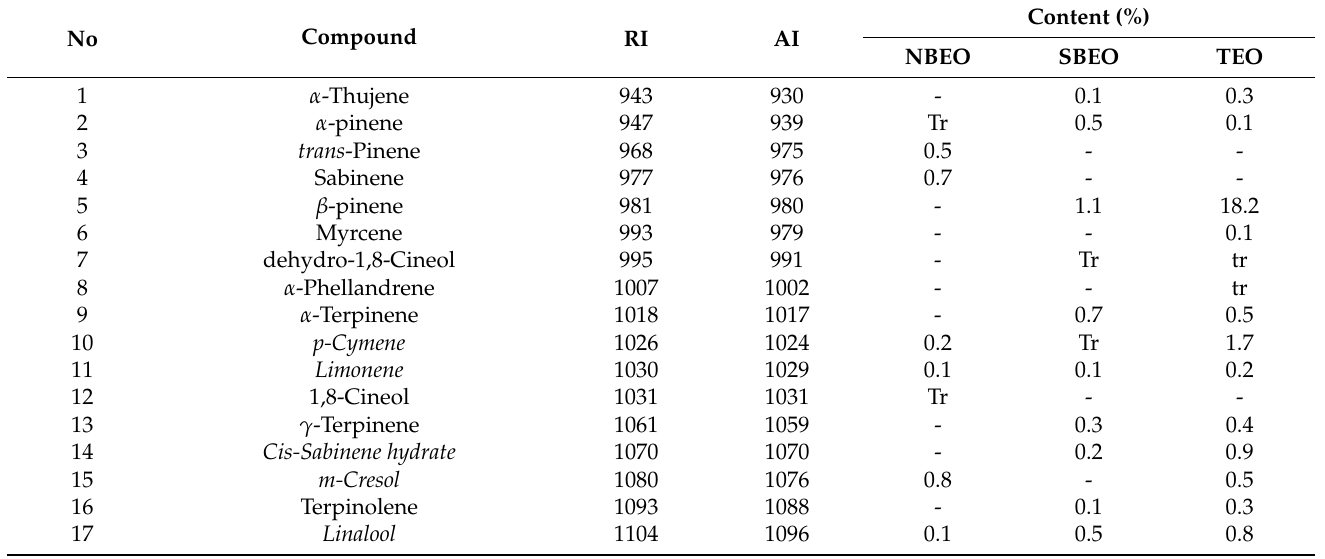
Table 2. The chemical profiles of essential oils extracted from Pimpinella lutea (Desf.) subspecies from various locations of